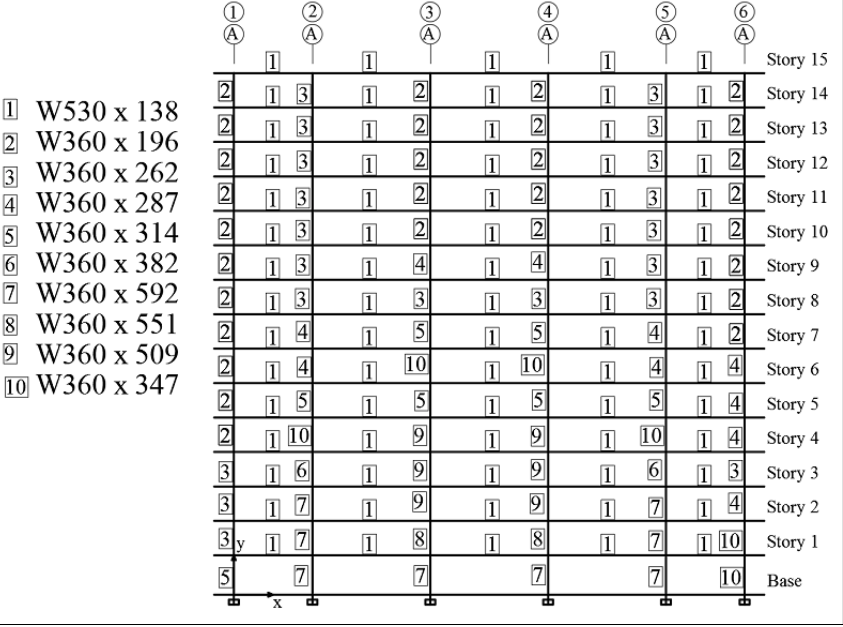
Figure 3. Designed sections for frames at elevations A and H.